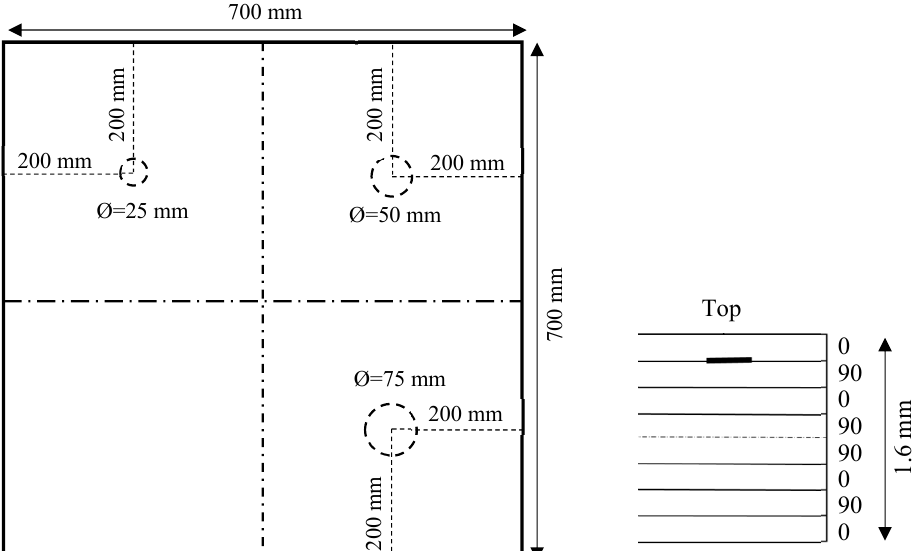
Figure 2. Schematic of a 1.6 mm cross-ply [0/90] 2s carbon fiber-reinforced polymer (CFRP) composite plate with three simulated delaminations of various sizes at the same depth. Table 1. Engineering constants of the unidirectional prepreg [5].